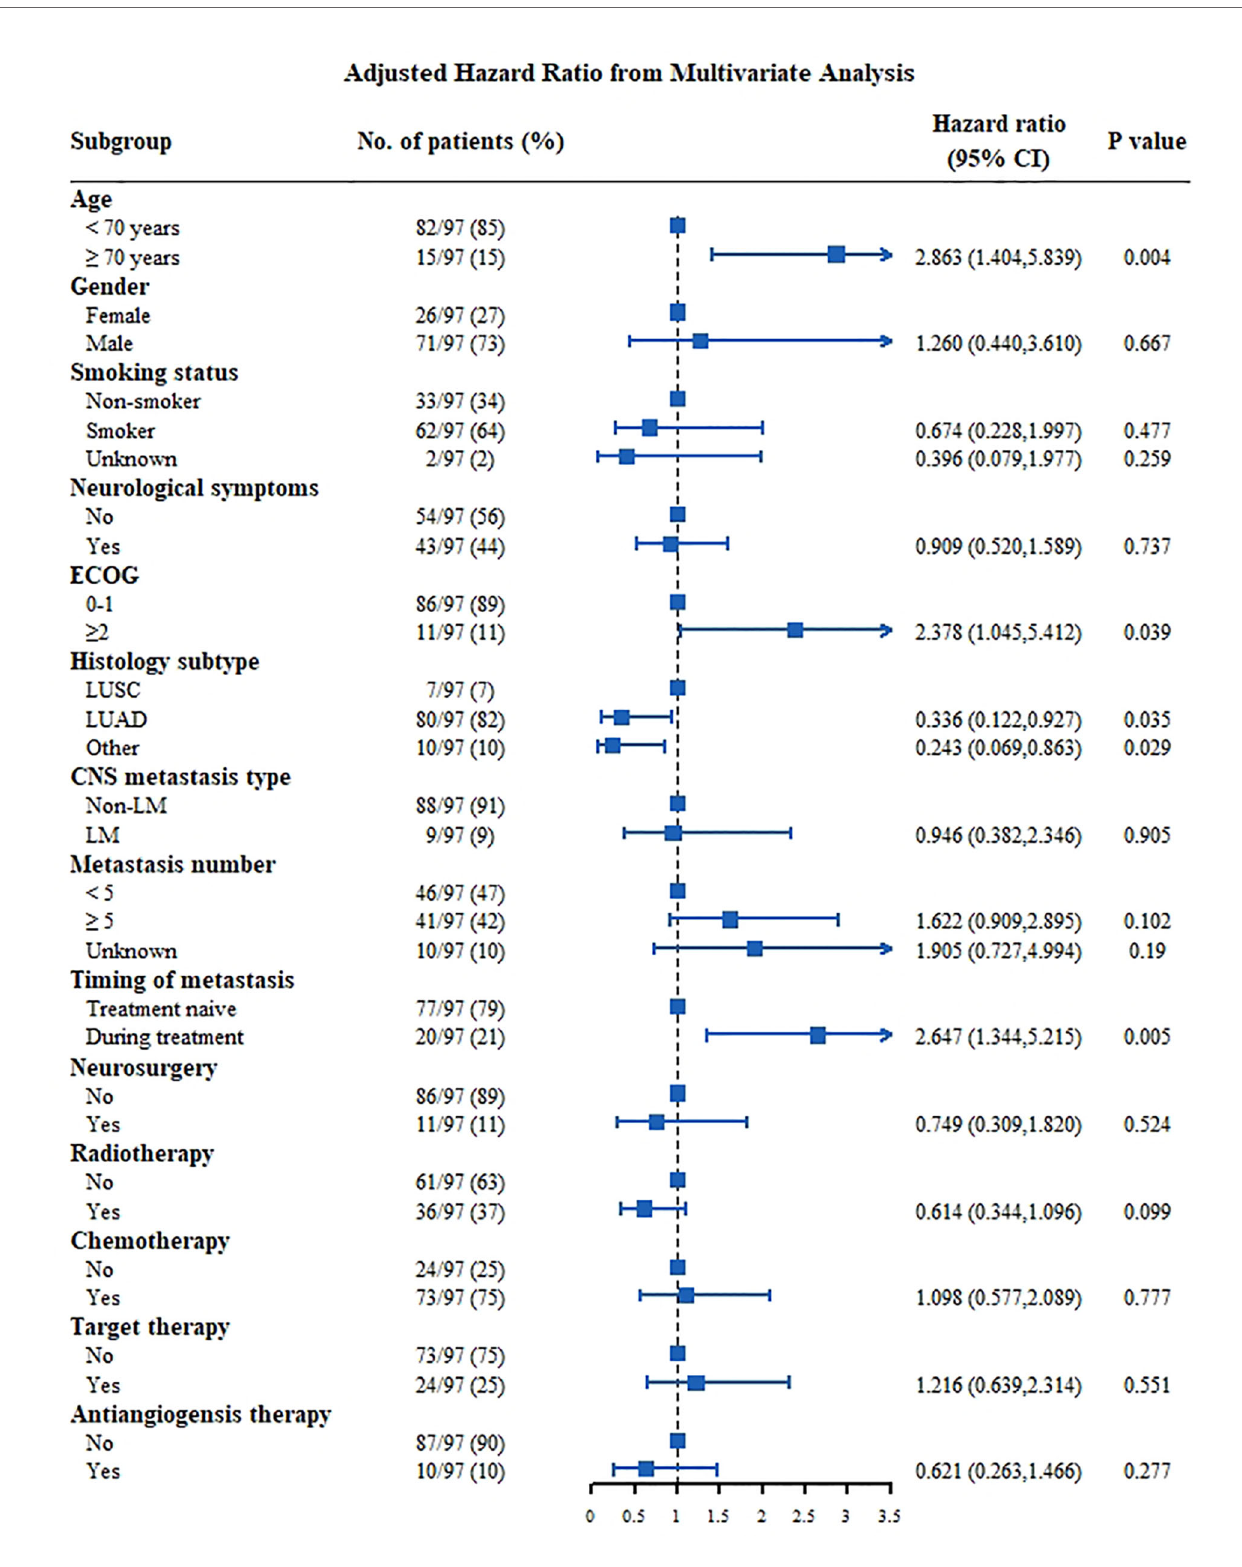
FIGURE 5 | Multivariate analysis Cox proportional hazards for OS in NSCLC patients with CNS metastasis of negative driver genes group. CNS, central nervous system; ECOG, Eastern Cooperative Oncology Group; LM, leptomeningeal metastasis; LUAD, lung adenocarcinoma; LUSC, squamous cell lung carcinoma.